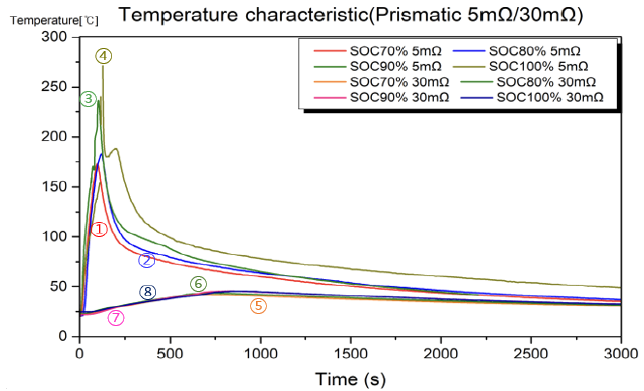
Figure 9. Temperature status of prismatic cells during testing with SOC and short-circuit re- sistance.